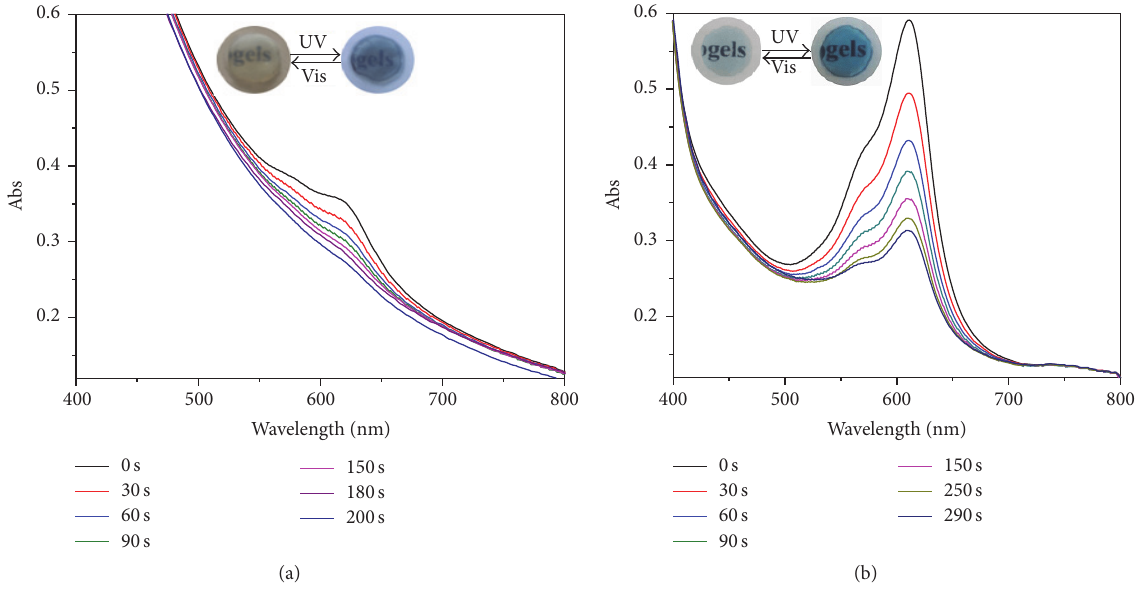
Figure 4: Absorption spectra with irradiation time for (a) immersing method and (b) polymerization